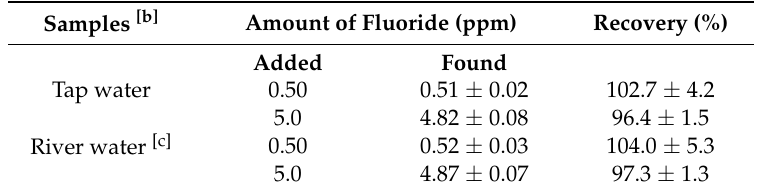
Table 2. Determination of the fluoride anion in tap water and river water samples ( n = 3) [a]